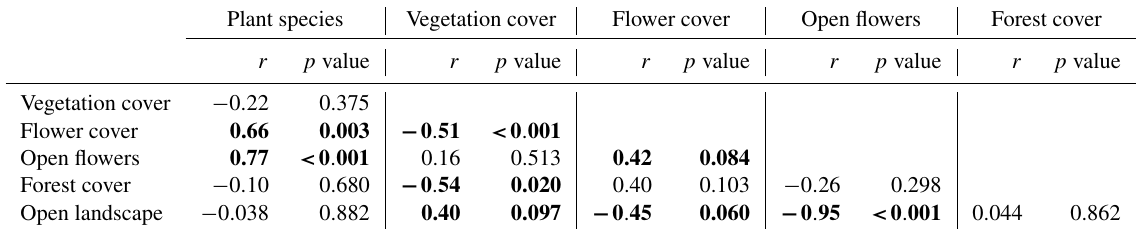
Table 1. Correlation between plant and landscape parameters. Significant and marginally significant r and p values are pointed out in bold.